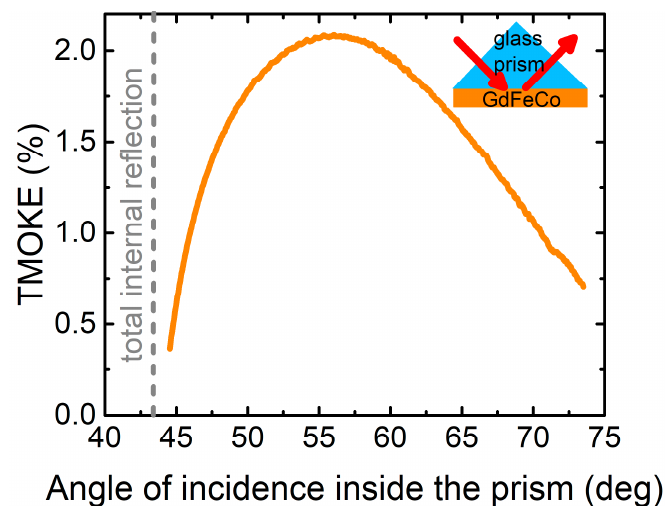
Figure A1. Experimental measurement of the transverse magneto-optical Kerr effect (TMOKE) enhancement near the SPP excitation angle (55 deg) for 800 nm wavelength. The inset shows the measurement configuration.